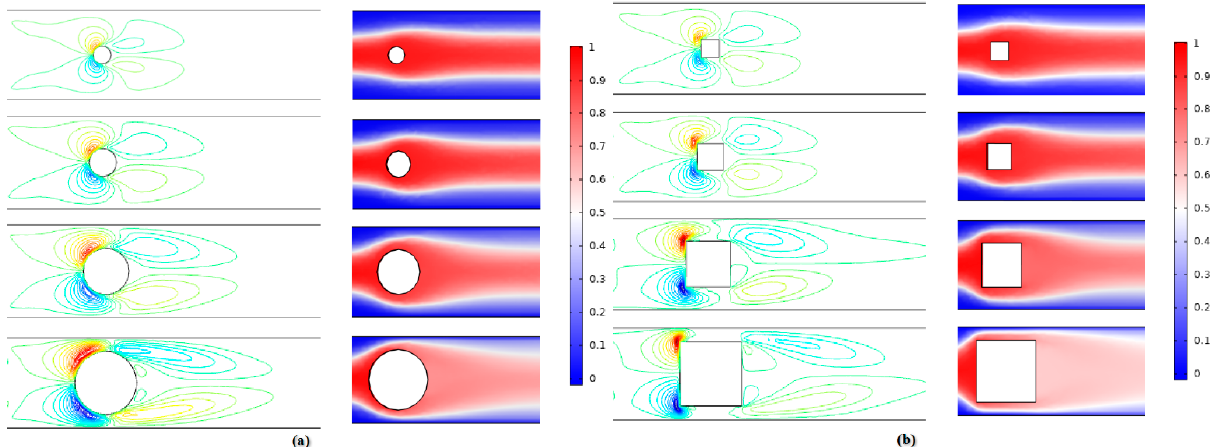
Figure 18. Transverse velocity (left column) and concentration contours (right column) in the micromixers with ( a ) cylinder and ( b ) square obstacles at Re = 50.